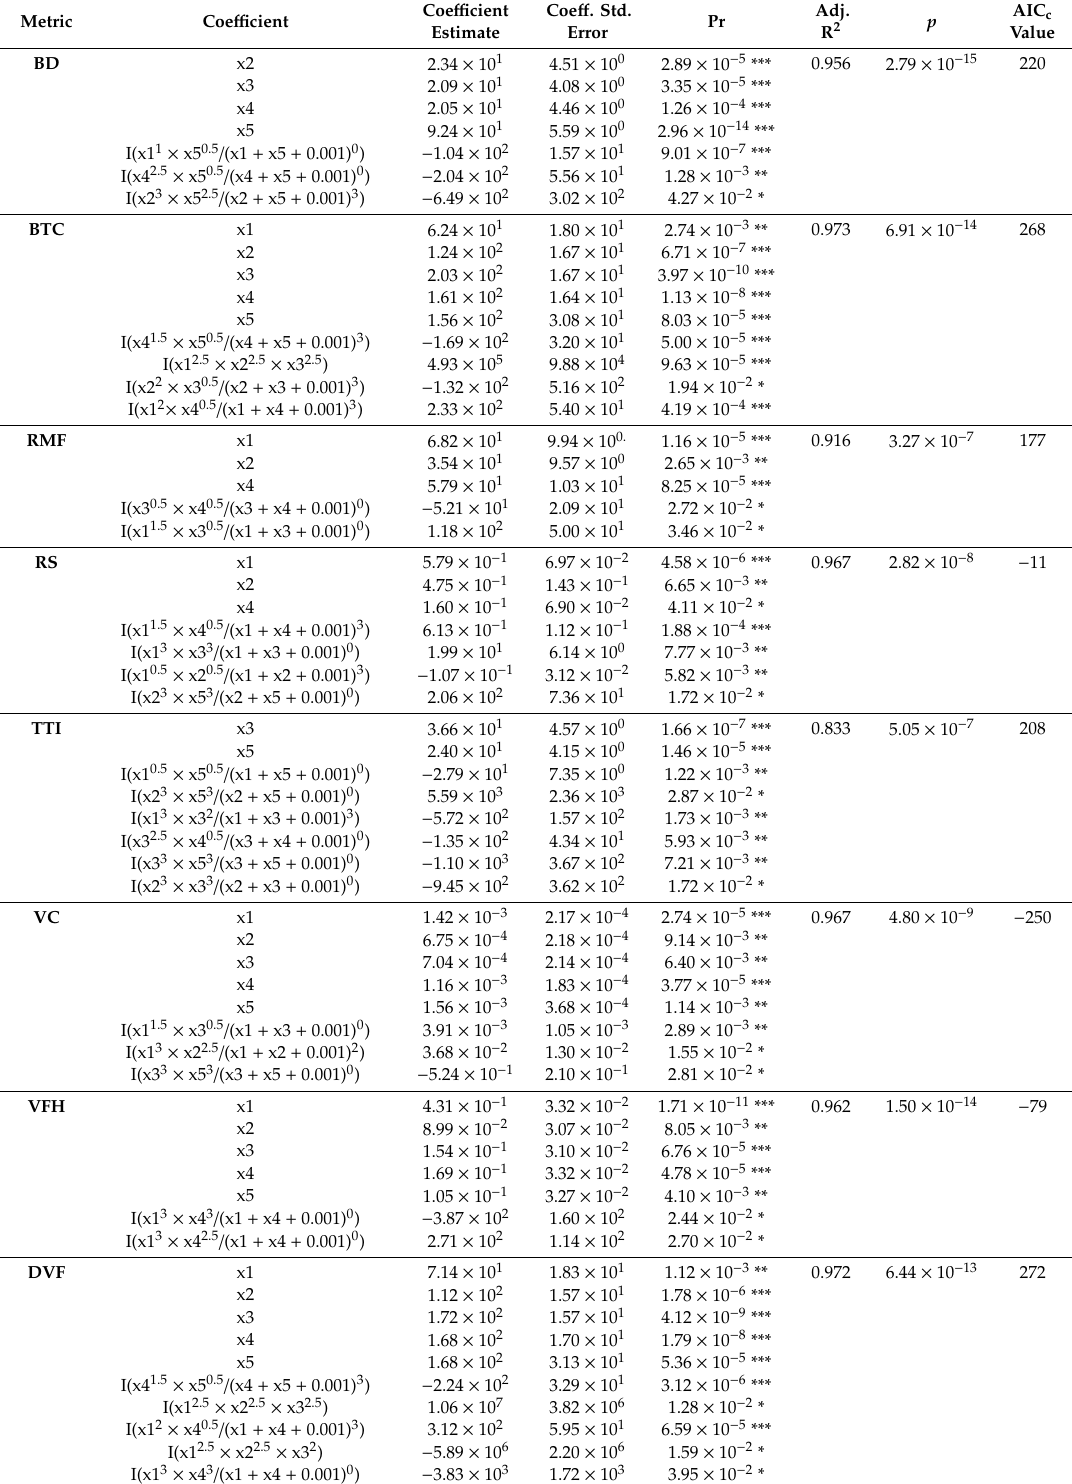
Table 7. Model outputs for Rofe Park for bulk density (BD), burn to completion (BTC), residual mass fraction (RMF), rate of spread (RS), time-to-ignition (TTI), volume consumed (VC), vertical flame height (VFH) and duration of visual flaming (DVF). x1 is cladodes, x2 is other, x3 is twigs, x4 is leaves, x5 is decomposed material, statistical significance codes: 0 “***”, 0.001 “**” 0.01 “*”, AIC c is the Akaike information criterion for small sample